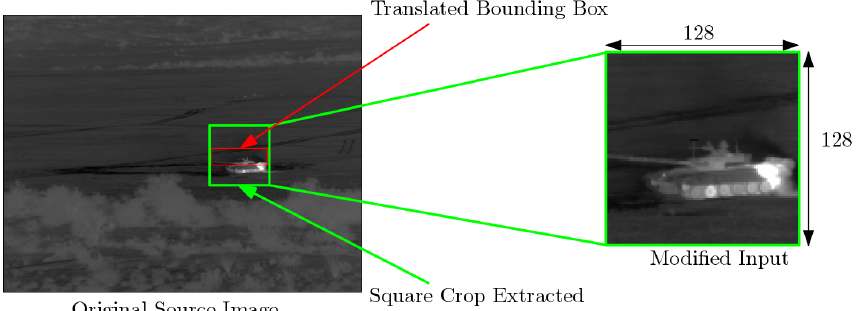
Figure 4. An extraction of target exemplars accounting for localization errors: We consider here an upward translation by a factor of 0.3 of the height of the bounding box; we depict both the original bounding box (red) and the translated bounding box (green).